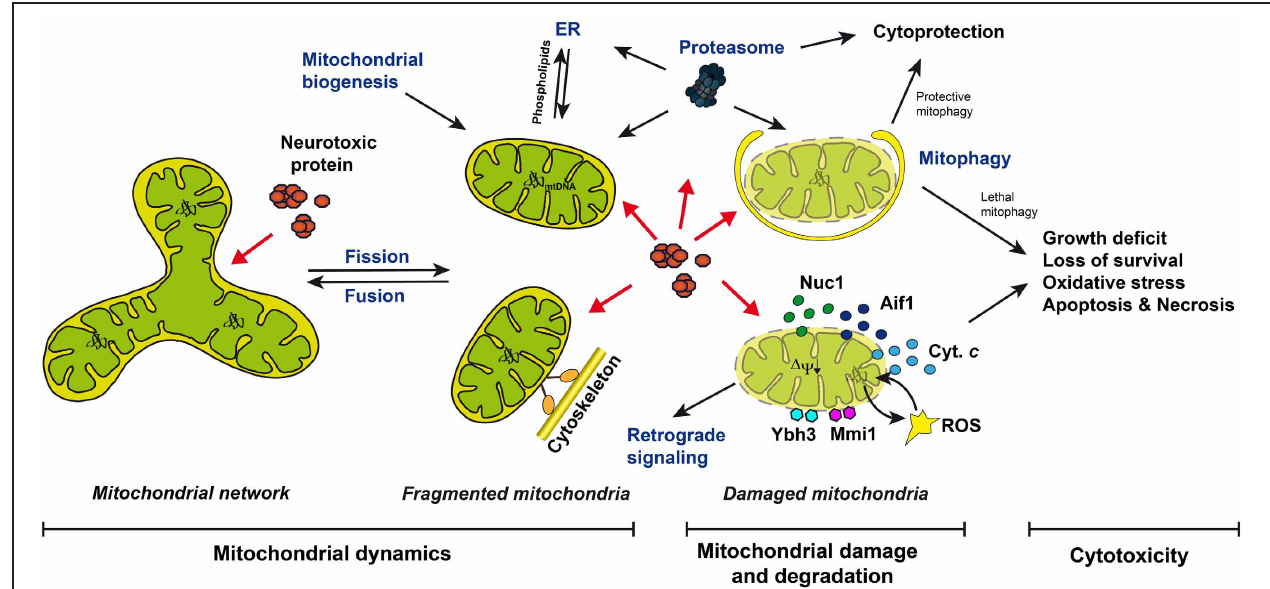
necrosis. Mitophagy and proteasome-dependent pathways remove damaged mitochondria, and mitochondrial biogenesis and retrograde signaling are involved in the replenishment and repair of the mitochondrial pool, respectively. Neurotoxic proteins trigger mitochondrial damage and cell death: they could interfere with mitochondrial fusion, fission, and motility, or could interrupt with mitochondrion degradation triggering “lethal mitophagy”, or could directly affect mitochondrial